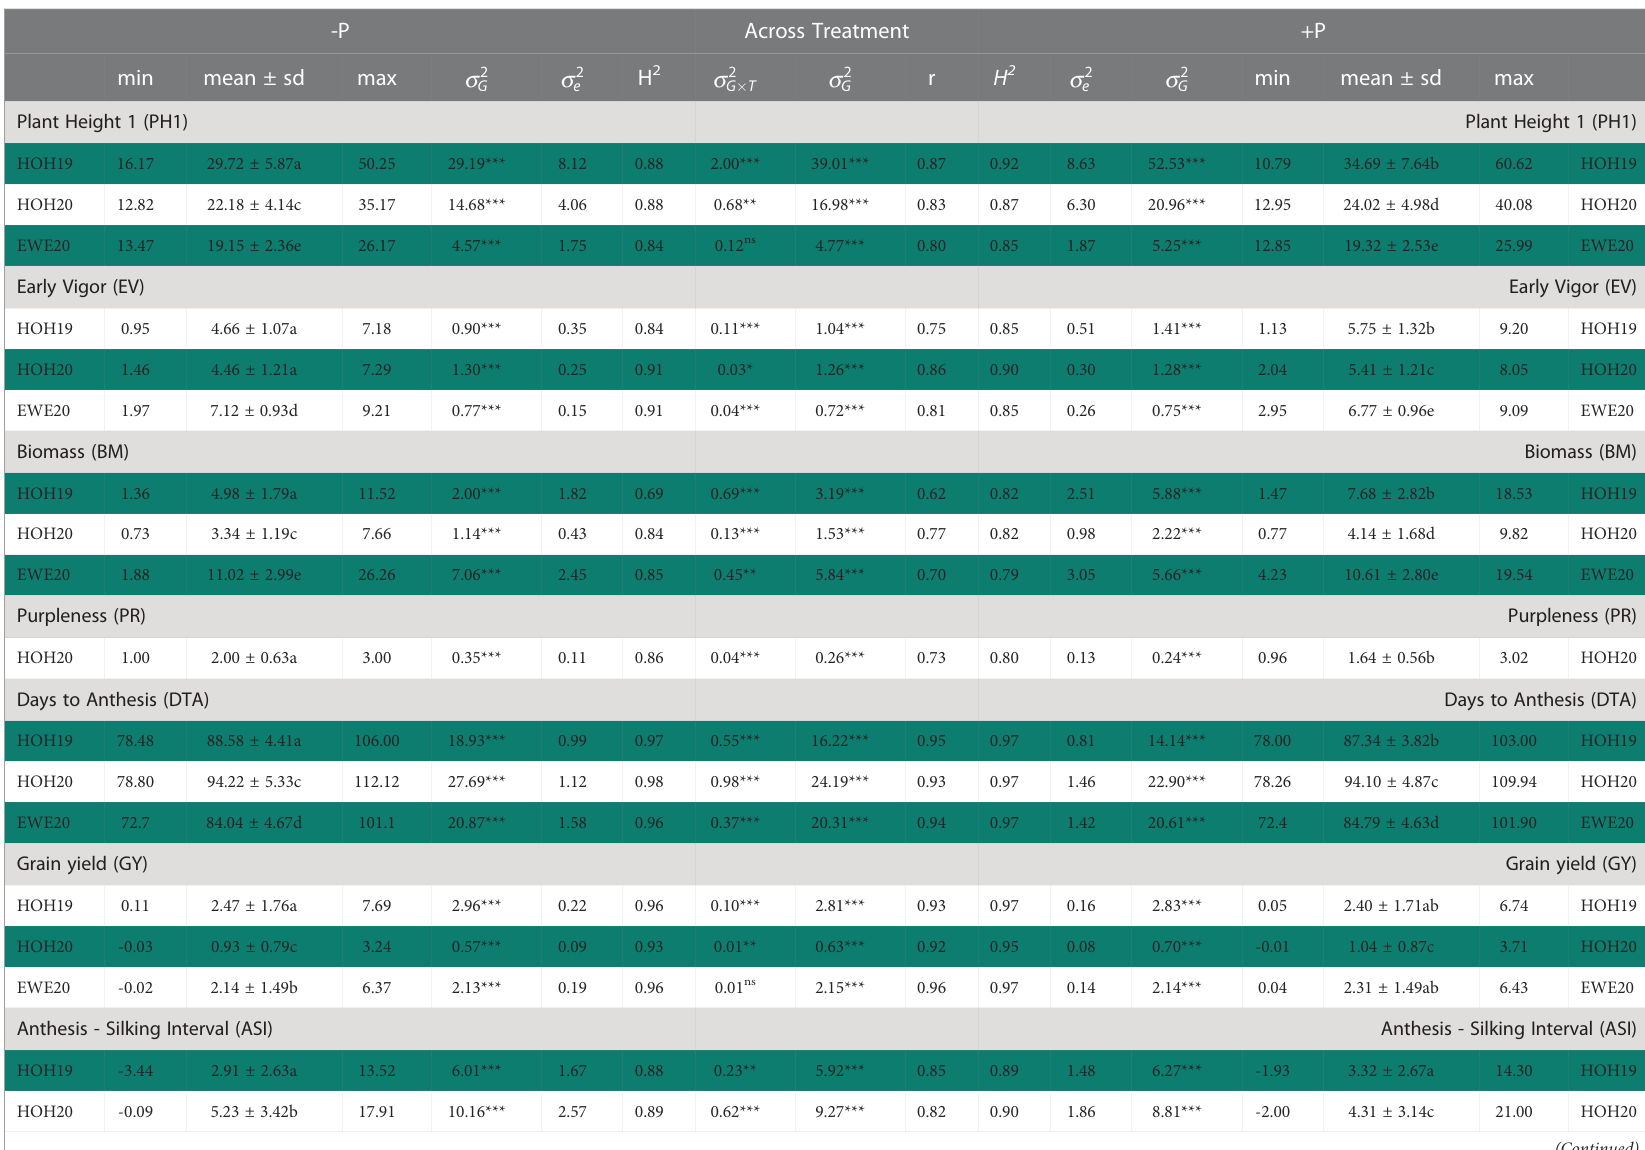
TABLE 2 Summary statistics for the evaluated traits. -P Across Treatment +P min mean ± sd max s 2 G